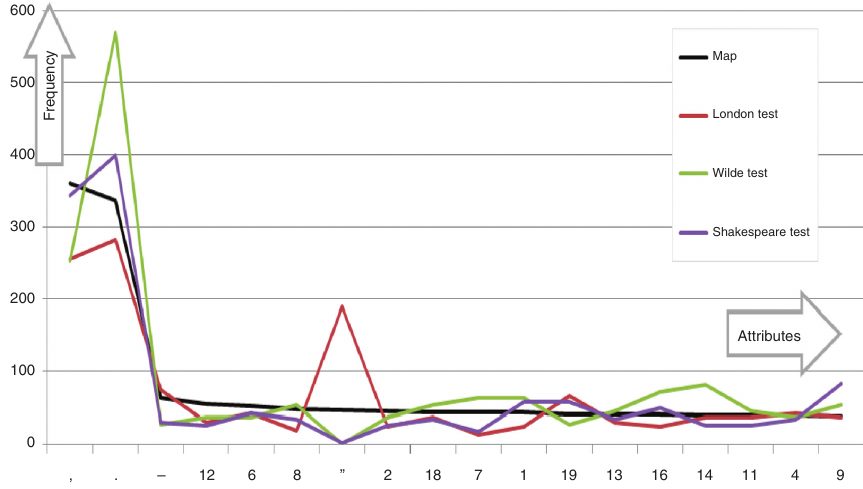
Figure 3: Wilde’s Map vs. Authors’ Test Books.